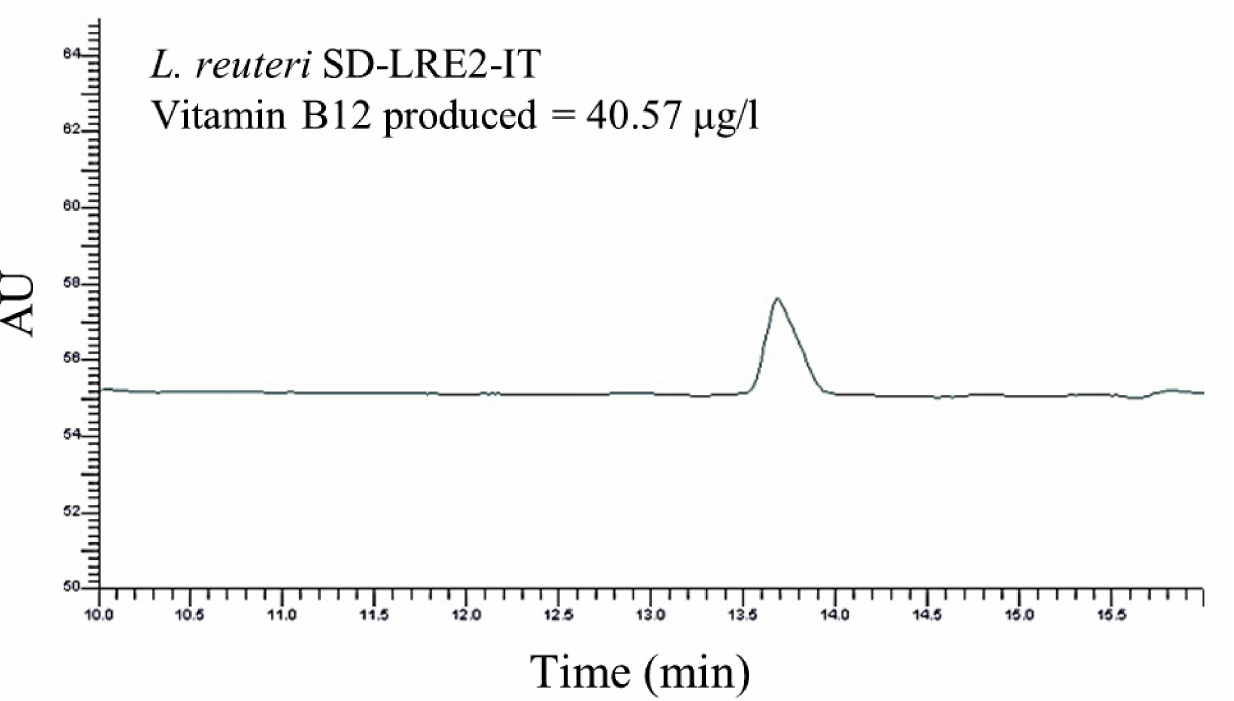
Figure 4. HPLC-based confirmation of vitamin B12 (cyanocobalamin) production by L. reuteri SD-LRE2-IT after it was grown in B12-free chemically defined medium, as outlined in 4.5. AU = arbitrary